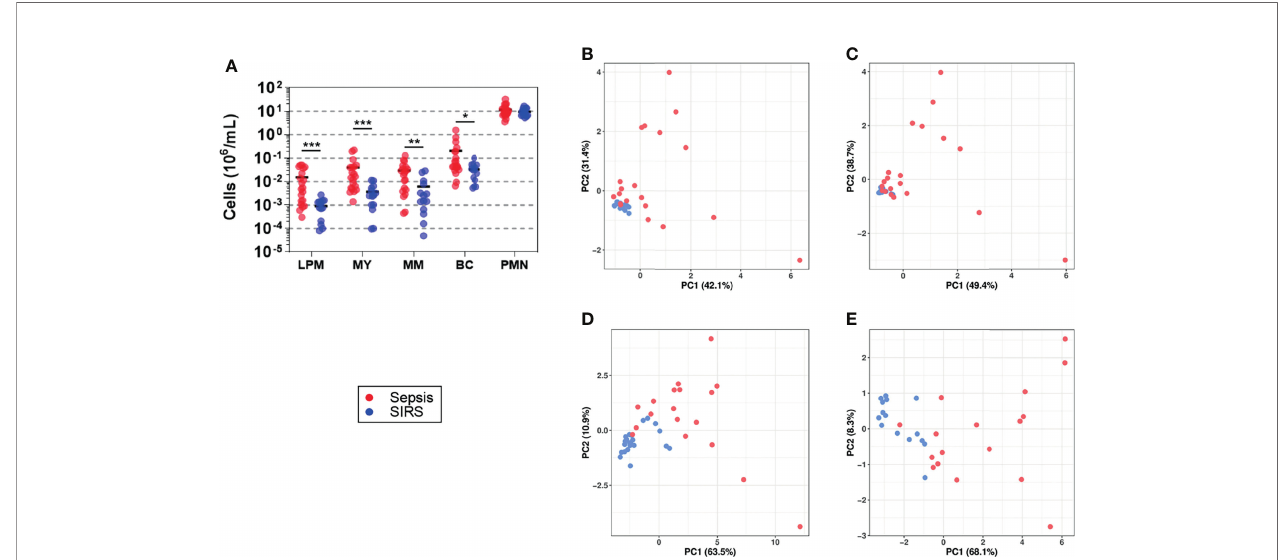
FIGURE 4 | Blood counts of granulocyte precursors (sepsis, n = 20; SIRS, n = 14). (A) Stages of terminal granulocytic differentiation were determined in whole blood by fl ow cytometry ( Supplementary Figure S1 ) (LPM, late promyelocyte; MY, myelocyte; MM, metamyelocyte; BC, band cell; PMN, polymorphonuclear neutrophil). Absolute counts per blood volume were determined using BD TruCount beads and are shown as scatter plots with horizontal black lines indicating group means. *** p < 0.0005; ** p < 0.005; * p < 0.05 after Mann – Whitney U test. PCA plots show the fi rst two principal components (PC1 and PC2) corresponding to the CD15 cell count data shown in (A) , either including (B) or excluding (C) PMNs and corresponding to expression levels of genes with validated differential expression contained in validation subset A (D) and subset B (E) ( Supplementary Table S1 ). The percentage of the overall variance explained by PC1 and PC2, respectively, is given in parentheses. Throughout, sepsis patients are indicated in red and SIRS patients in